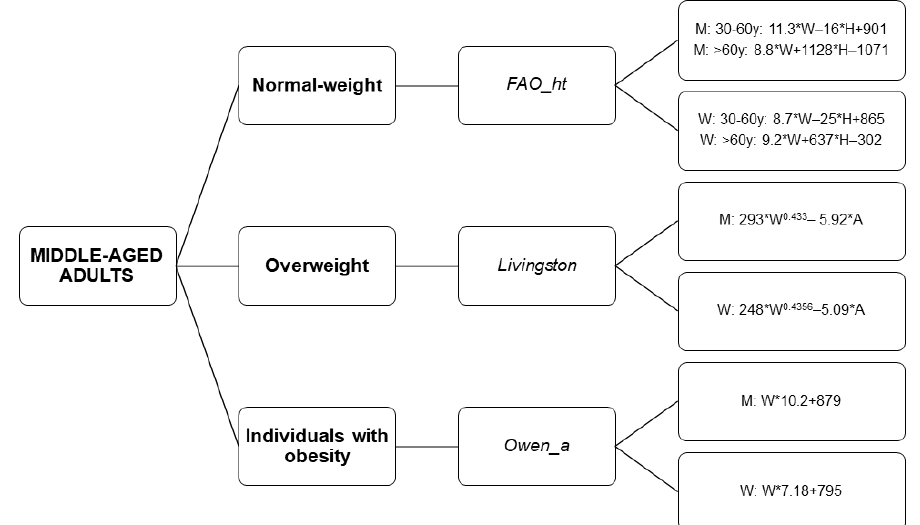
Figure 6. Decision tree to select a REE predictive equation by weight status. “_a” refers to predictive equations which require only anthropometric parameters to calculate REE, and “_ht” refers to predictive equations which are proposed by the same author and include height. Abbreviations: M: Men; W: Women; W: Weight; H: Height; A: Age; y: years.